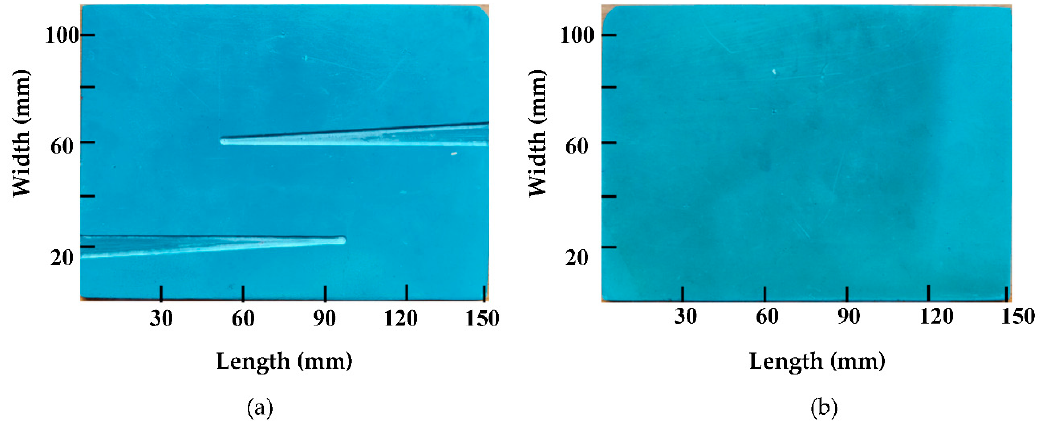
Figure 5. Photos of a polyvinyl chloride (PVC) test specimen: ( a ) The surface backs to IR camera; ( b ) The surface facing the IR camera.